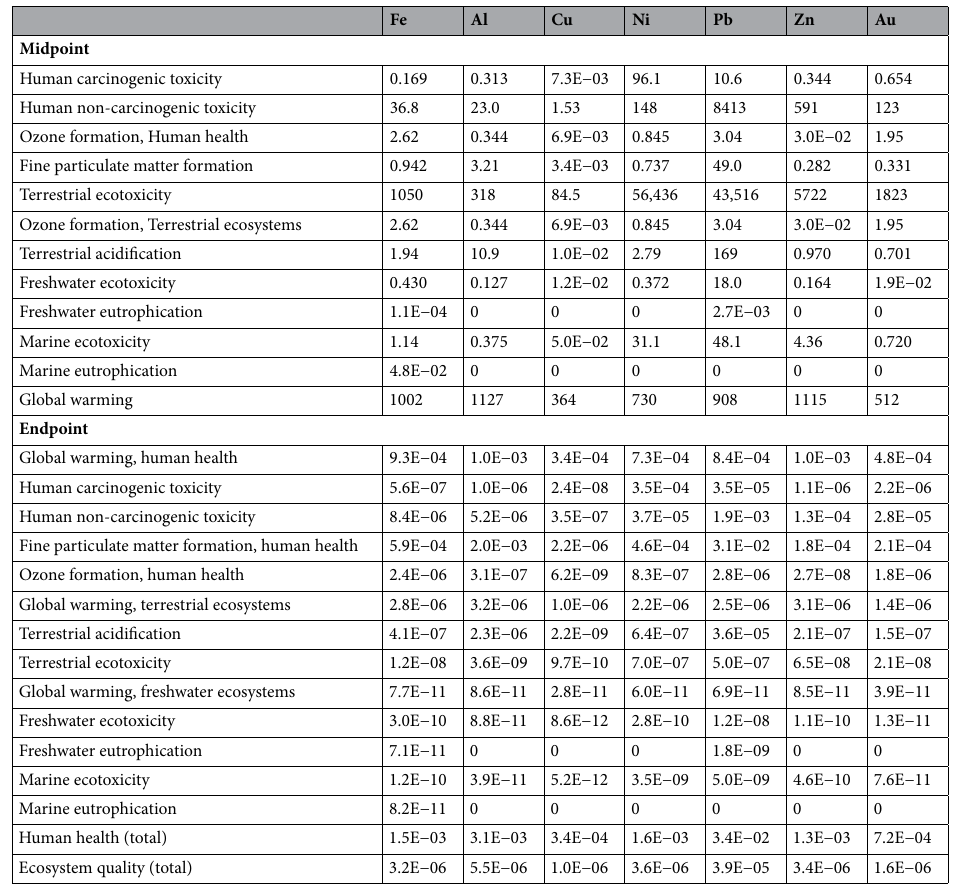
Table 6. Environmental impact assessment of metal producing industries expressed on per US$1000 of metal market value.